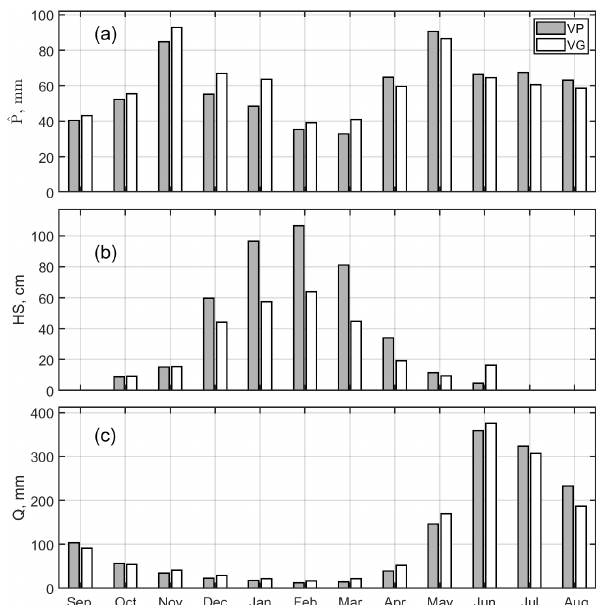
Figure 2. Average monthly cumulative precipitation (a) , snow depth (b) , and cumulative reconstructed streamflow (c) for Beaure- gard and Valpelline. Precipitation was calculated across all gauges in the valleys of Beauregard and Valpelline (variable ˆ P ; see gauge locations in Fig. 1). Snow depth was from two representative, mid- elevation sensors (elevation was ∼ 1860 and 1970ma.s.l. for the snow depth sensor of Beauregard and Valpelline, respectively). Re- constructed streamflow refers to the hydropower catchments delin- eated in Fig. 1. The reference period used for these statistics varied from variable to variable due to data gaps (see Sect. 4.1 for details). VG and VP are Beauregard and Valpelline,